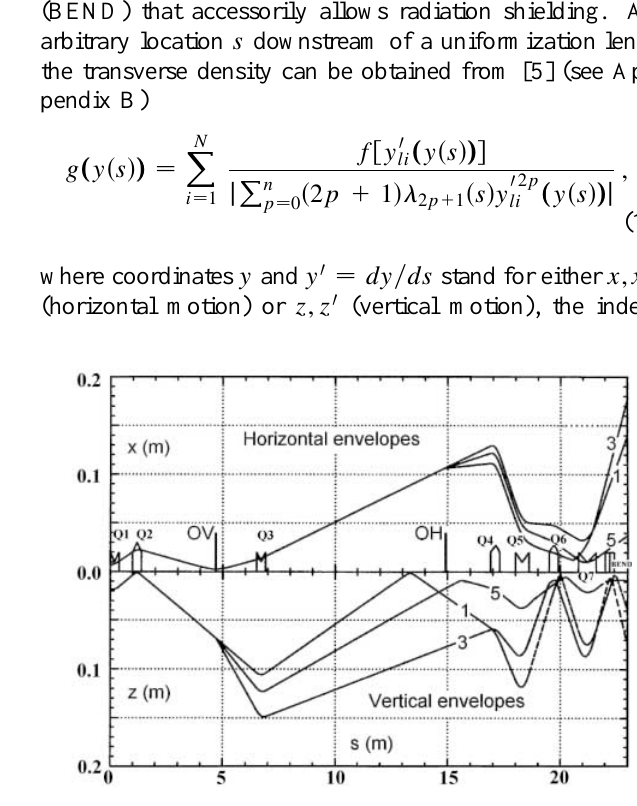
FIG. 1. Typical expander geometry, together with the horizon- tal envelopes X 1,3,5 (cid:1) s (cid:2) (upper curves) and the vertical envelopes Z 1,3,5 (cid:1) s (cid:2) (lower